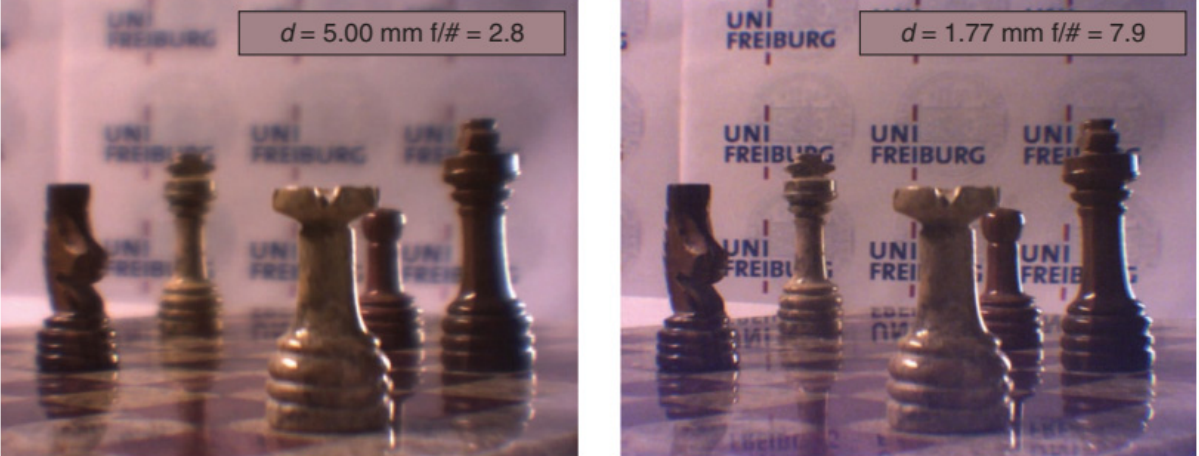
Figure 20. Scene captured by the model constructed by Petsch et al. for aperture tuning using the fluidic iris: variation in the measured DOF for iris diameters of 5.00 ( left ) and 1.77 mm ( right ). All figures and the background text are in focus for d = 1.77 mm. The distance between the front and rear figures is 220 mm. Light: Science and Applications 2016, 5, e16068–e16068 ([62]). Originally published by and reprinted with permission from Springer Nature.